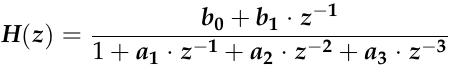
Table 1. Coefficients of the FTs provided by the system identification process.